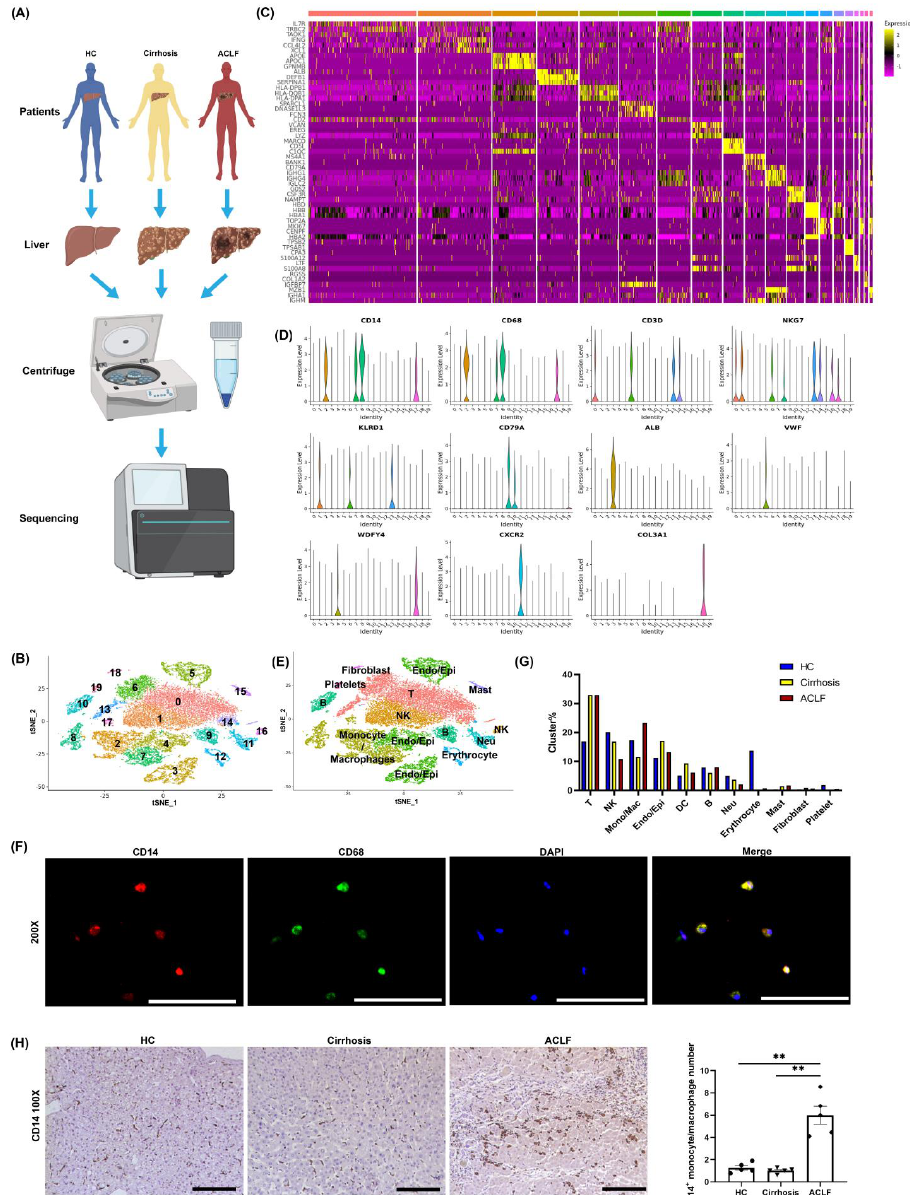
Figure 2. scRNA-seq revealed that a large number of monocyte/macrophages infiltrated into ACLF liver . ( A ) The workflow of scRNA-seq analyses. NPCs isolated from 5 ACLF livers, 3 cirrho- sis livers, and 2 HC livers were included in this study. ( B ) 26,200 cells from HC ( n = 2), cirrhosis ( n = 3), and ACLF ( n = 5) human livers were divided into 20 clusters (0–19), shown by tSNE plotting. ( C ) The representative marker genes of 20 subpopulations are presented with a heat map. Each col- umn represents a different cell cluster and is arranged in the order of 0–19. ( D ) The classical marker genes of each cluster: CD14 and CD68 for monocyte/macrophages, CD3D for T cells, CD79A for B cells, NKG7 and KLRD1 for NK cells and T cells, ALB and VWF for epithelial tissue cells (including epithelial cell and endothelial cells), CXCR2 for neutrophils, WDFY4 for dendritic cells, COL3A1 for fibroblasts. ( E ) We re-annotated the 20 subpopulations according to their marker genes, and 11 classical clusters were annotated to facilitate the next analyses. ( F ) Cell immunofluorescence of CD14 and CD68 in isolated monocyte/macrophages from ACLF liver (200 × field). ( G ) The proportion of 11 classical clusters among HCs, cirrhosis patients, and ACLF patients. ( H ) IHC staining for mono- cyte/macrophages (CD14) in the liver of HCs, cirrhosis patients, and ACLF patients (100 × field). (** p < 0.01; bar = 200 µ